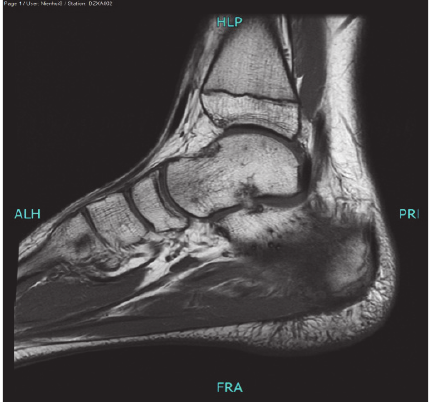
Figure 1: Plain radiograph: lateral view of the left foot: osteochon- droma located at the plantar side of the calcaneal bone.